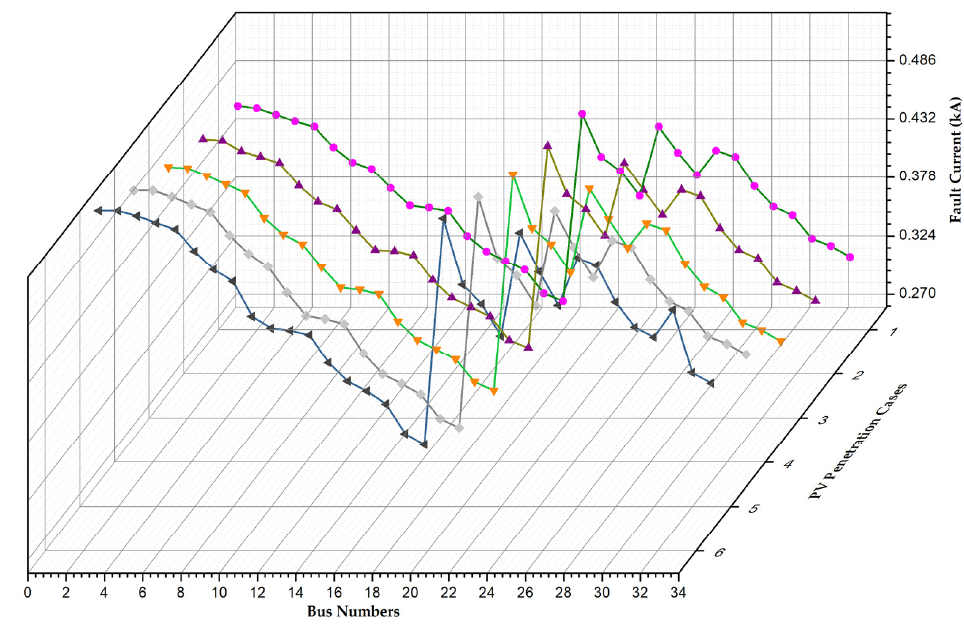
Figure 3. Fault current variation at every bus for each PV penetration case.